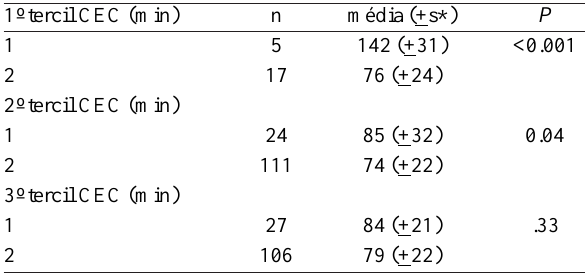
Tabela 4. Comparação entre tempo de CEC e presença de disfunção renal nas categorias de IMC